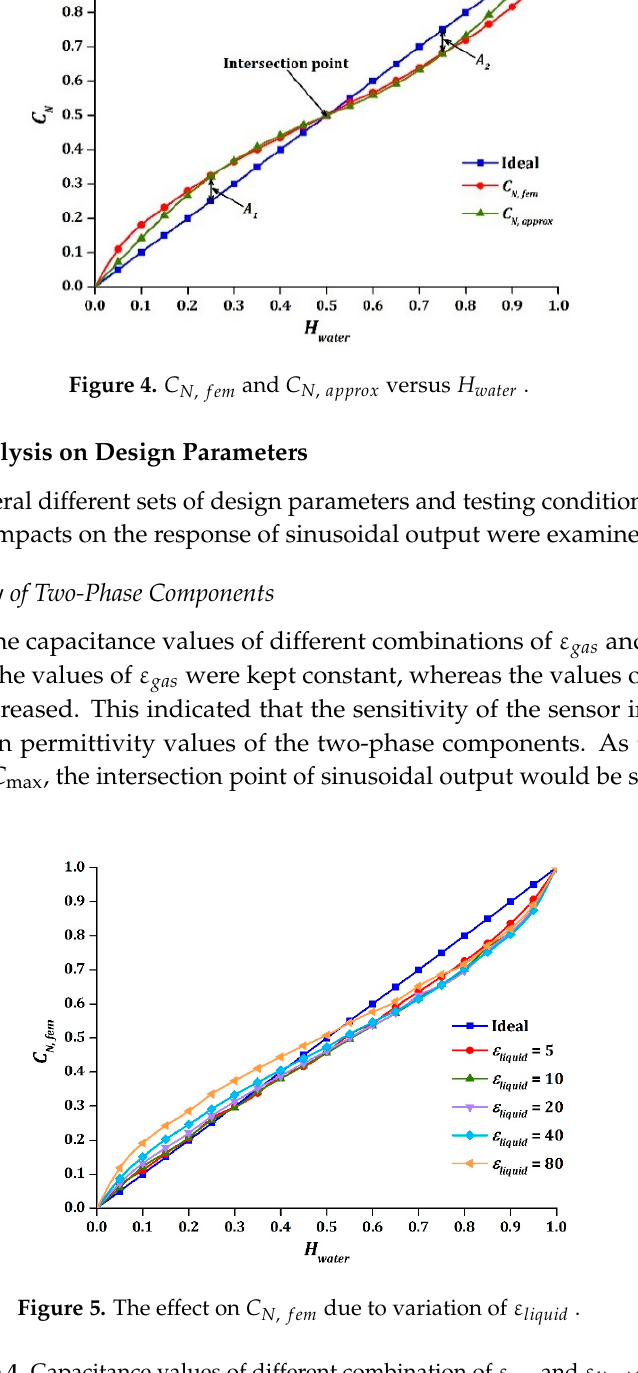
Figure 5. The effect on (cid:1829) (cid:3015),(cid:3033)(cid:3032)(cid:3040) due to variation of ε (cid:3039)(cid:3036)(cid:3044)(cid:3048)(cid:3036)(cid:3031) . Figure 5. The effect on C N , fem due to variation of Table 4. Capacitance values of different combination of ε gas and ε liquid